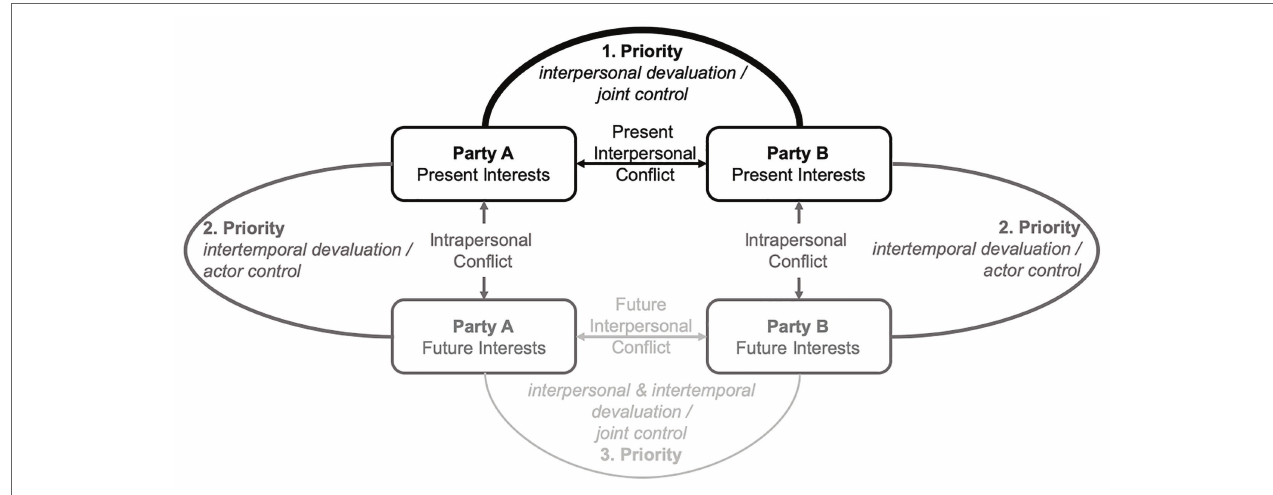
FIGURE 2 | Prioritized consideration of interdependent conflicts. We propose that parties prioritize present interpersonal conflicts (first priority) over intrapersonal conflicts (second priority) and future interpersonal conflicts (third